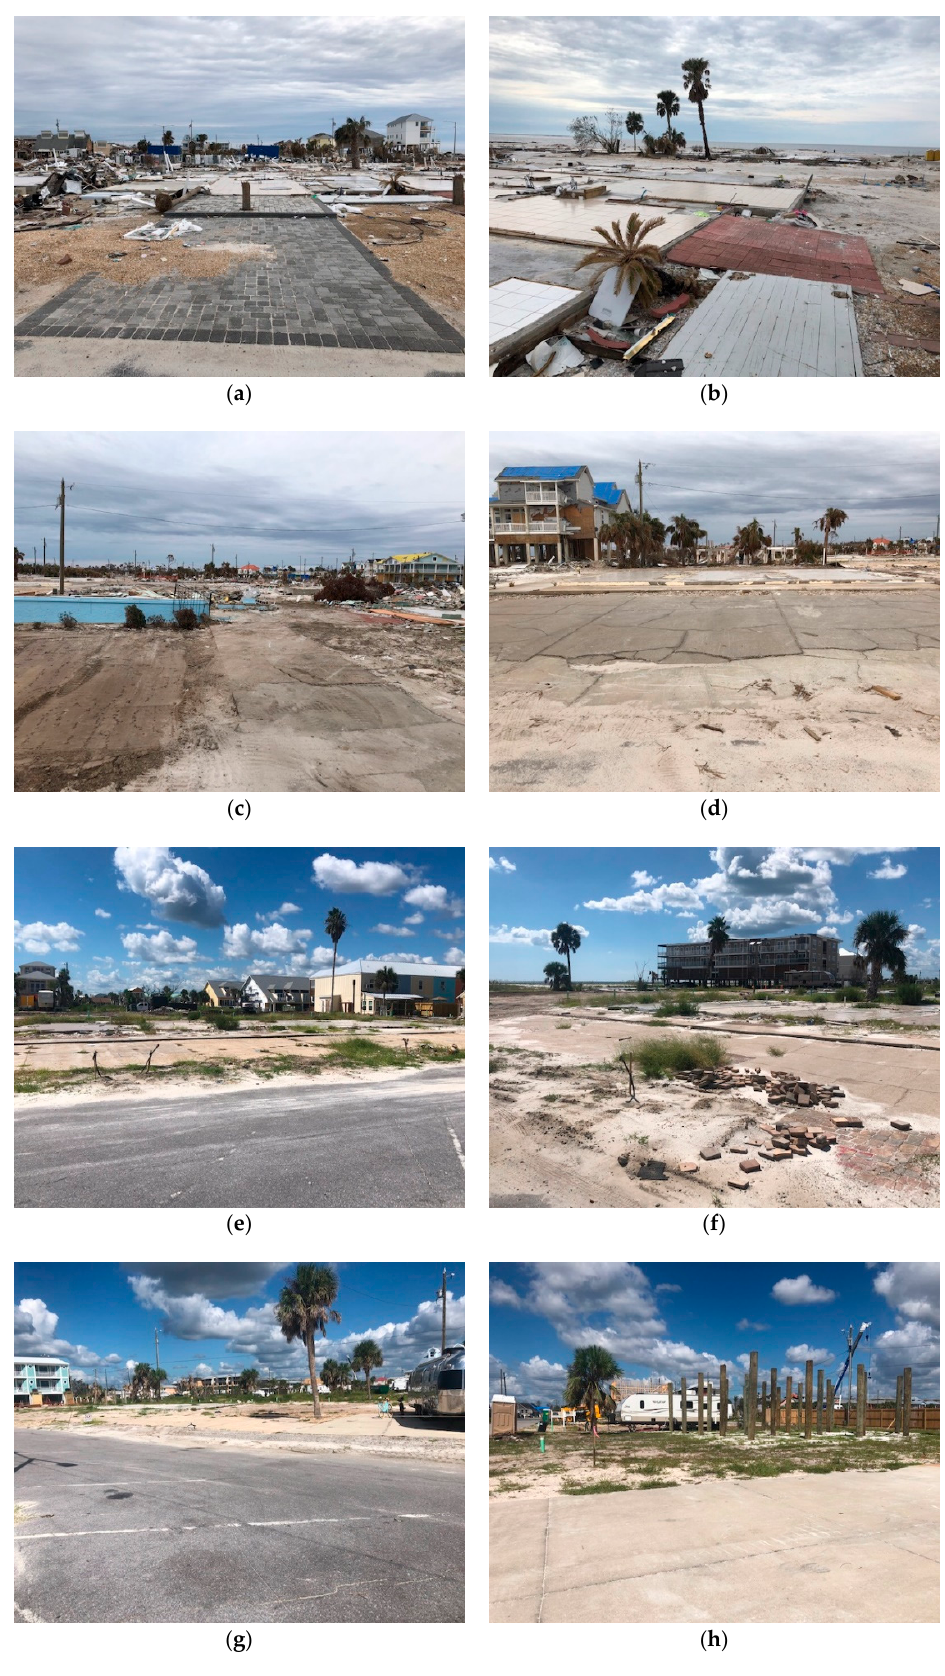
Figure 2. Mexico Beach storm surge damage zone in December 2018 ( a – d ). The same stretch of coastline in September 2019 ( e – h ). In September 2019, property had been mostly cleared of debris, and some owners were staying in campers ( g , h ) as they rebuilt.